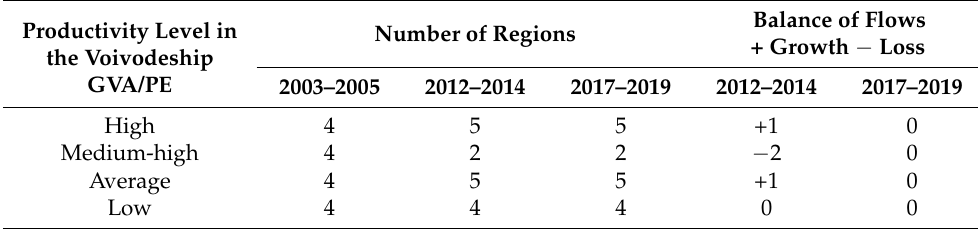
Table 5. Region flows between four groups of agricultural productivity between the initial and final period of 2003–2019 1